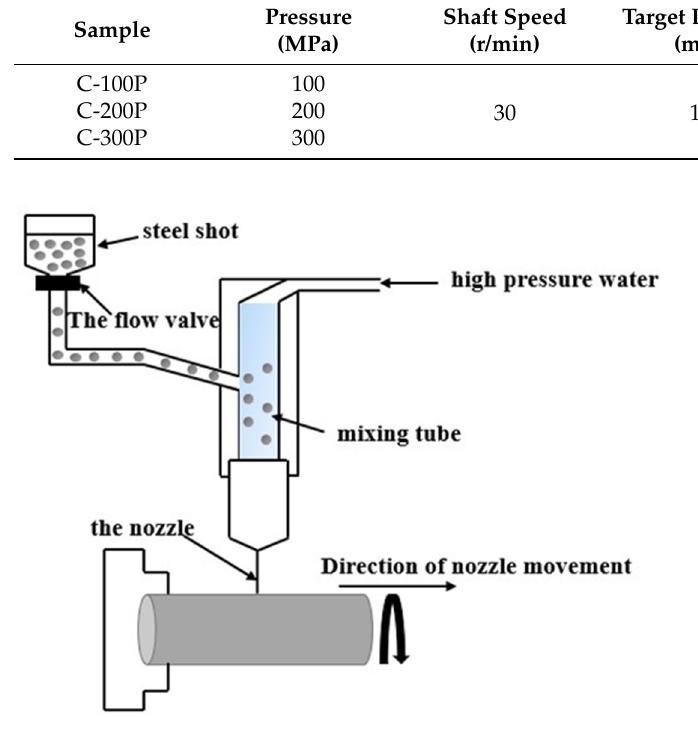
Figure 2. Schematic diagram of water jet blasting.